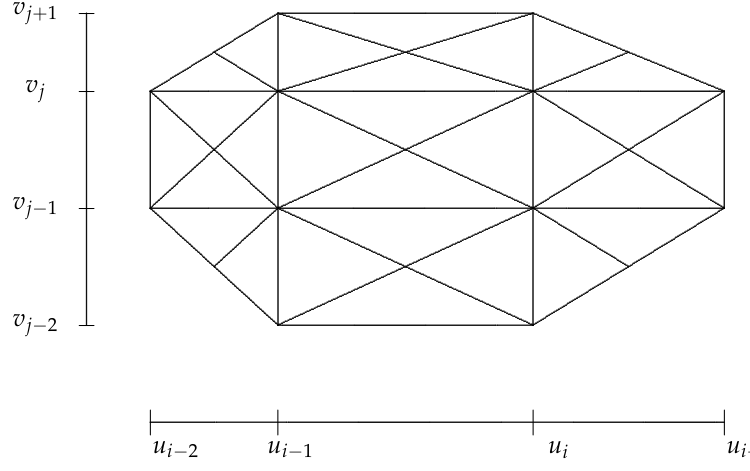
Figure 2. Octagonal support of the bivariate C 1 quadratic